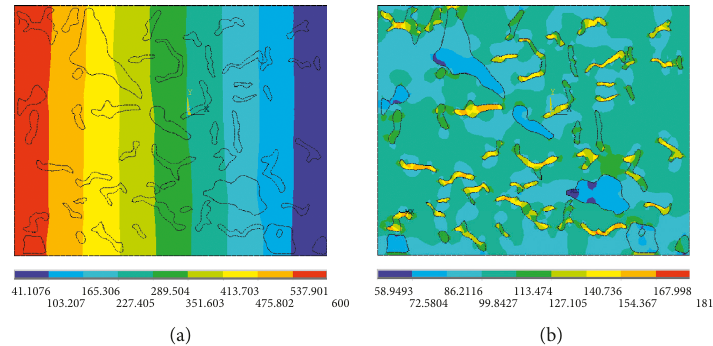
Figure 6: FE models with 10% pearlite without consideration of ICTC: (a) temperature field; (b) heat flux.